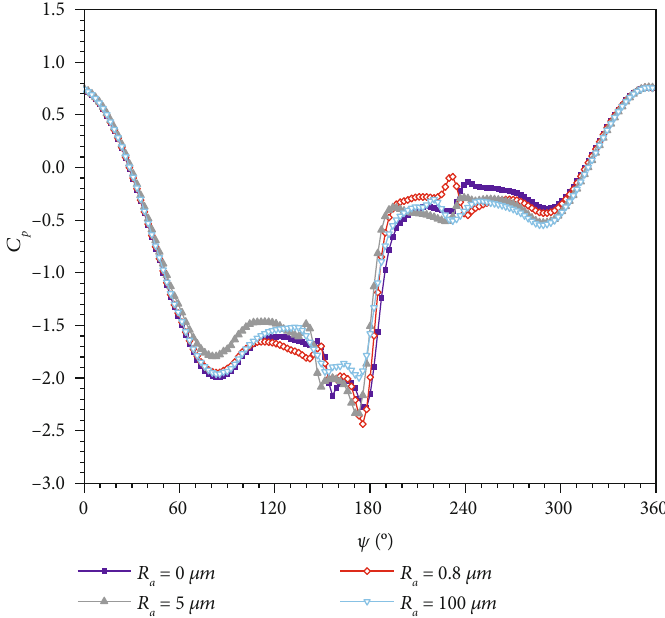
Figure 36: Pressure coe ffi cient distribution of di ff erent models at 3 D